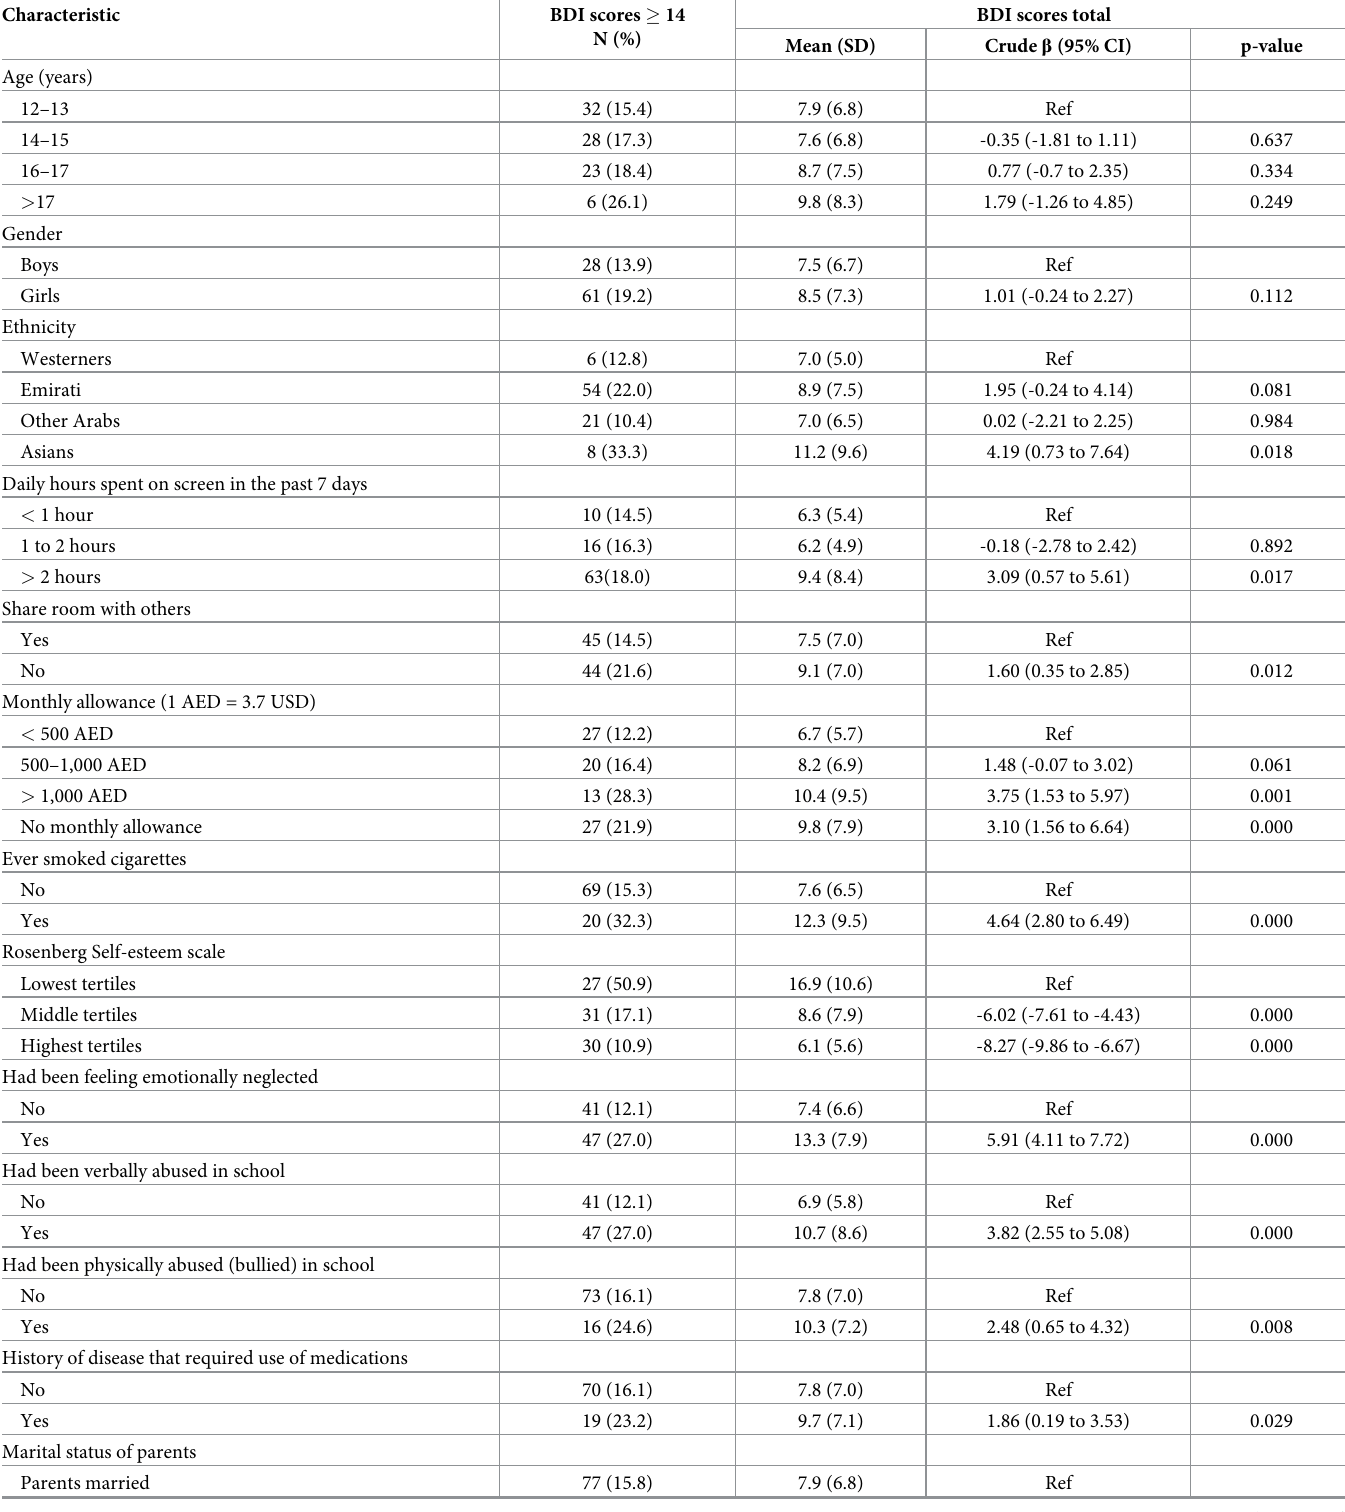
Table 3. Predictors of depressive symptoms ( β and95% confidence intervals) among adolescents aged 12–18 years (n = 518) in Al Ain, United Arab Emirates.